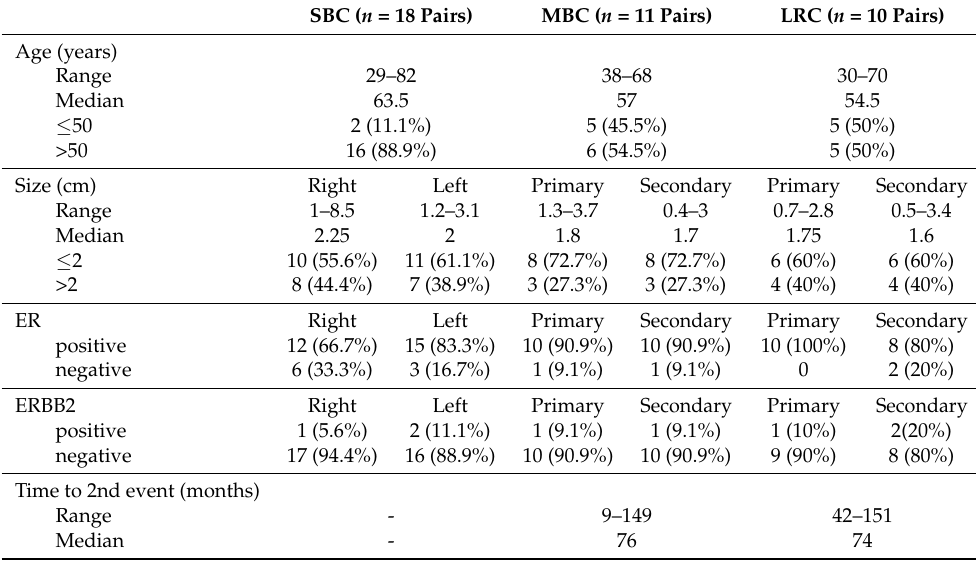
Table 1. Patient